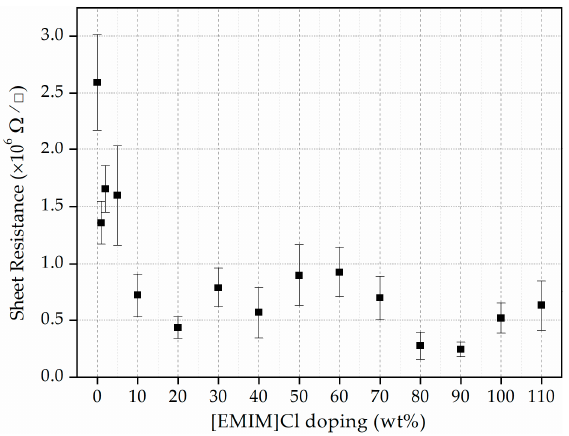
Figure 4. Sheet resistance of the asphaltene thin films as a function of [EMIM]Cl